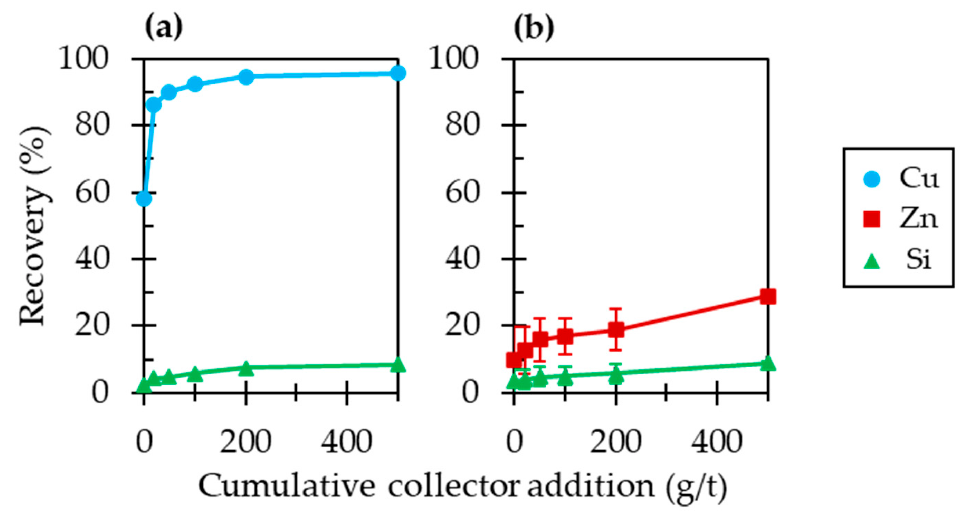
Figure 3. Results of single mineral flotation of ( a ) chalcopyrite or ( b )